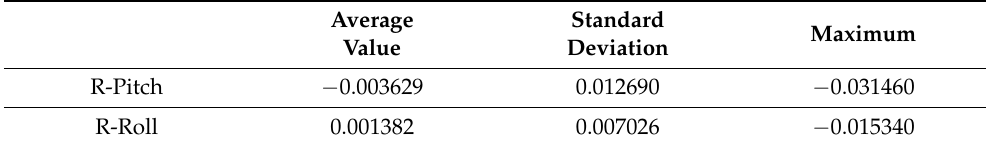
Table 3. The data from the IMU of robot.